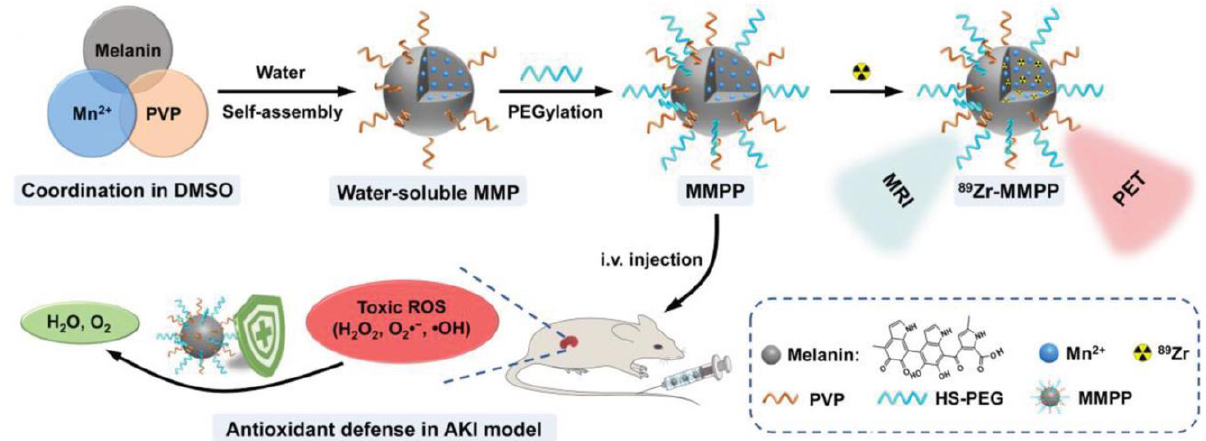
Figure 6. Synthesis and characterization of MMPP NP. Schematic illustration of the MMPP NP synthesis process and their activity as a naturally antioxidative platform for PET/MR bimodal imaging-guided AKI therapy. Reprinted with permission from ref. [107].